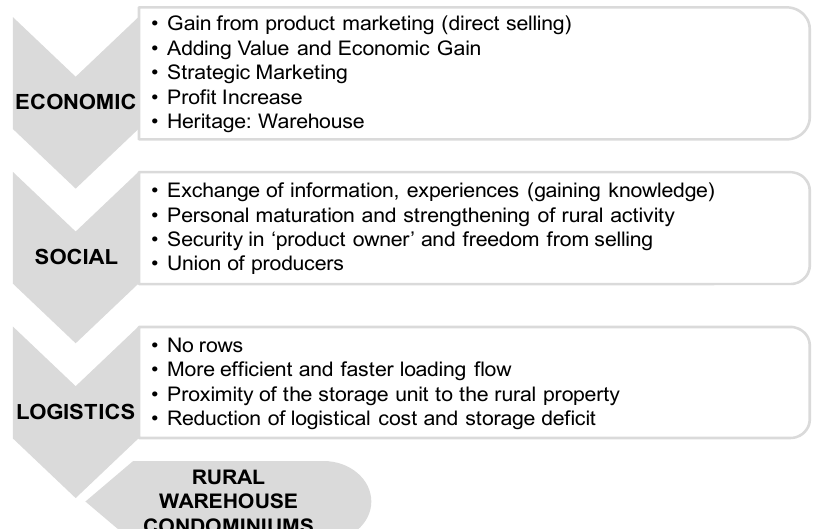
Figure 3. Determinants of Rural Warehouse Condominiums.